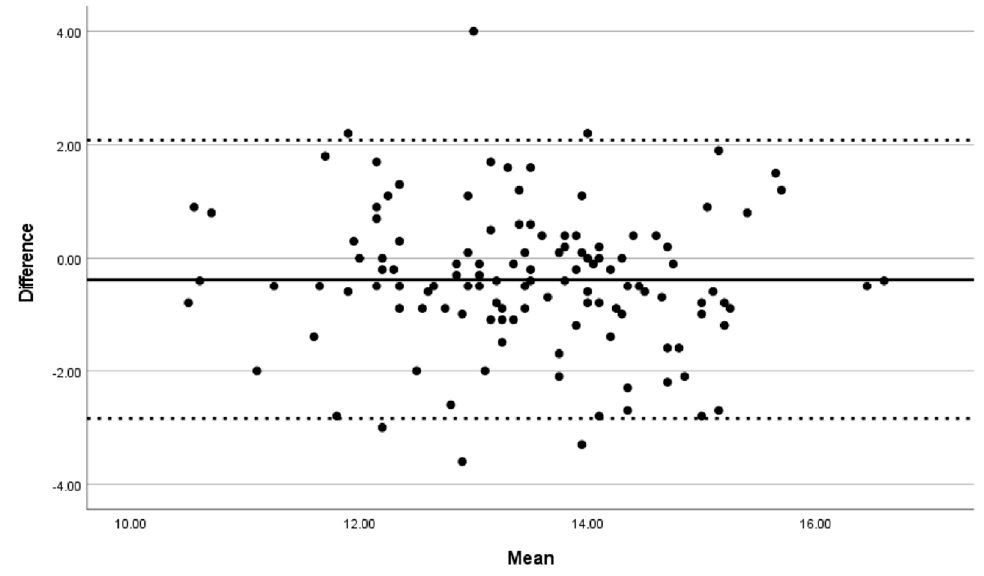
Figure 2. Bland–Altman plot showing the interobserver agreement. The bold line corresponds to the mean difference ( − 0.38 cm) and the dashed lines correspond to the upper and lower limits of agreement (95% LOA 2.08 to − 2.84 cm).